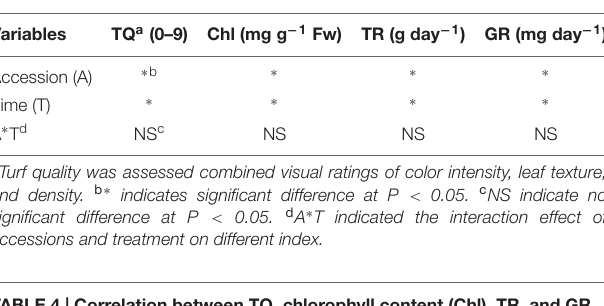
TABLE 3 | Summary of analysis of variance for the effects of accessions, treatment time and the interactions on turf quality (TQ), chlorophyll content (Chl), transpiration rate (TR), and growth rate (GR).